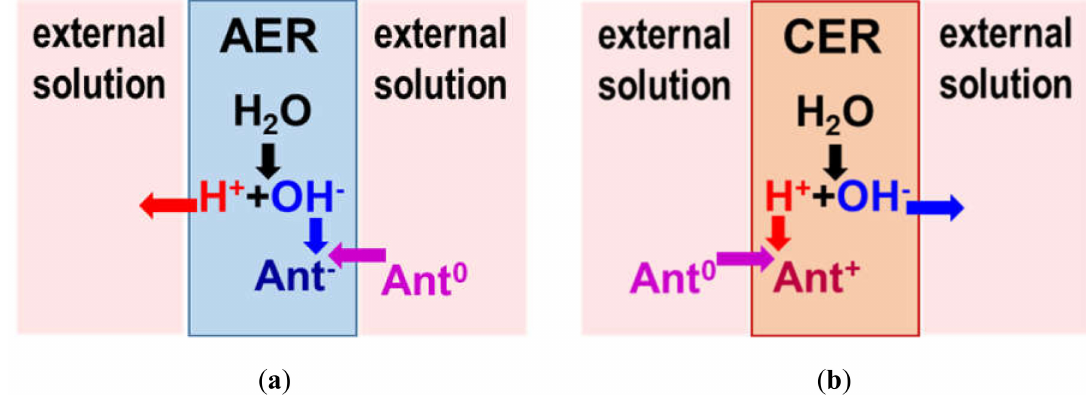
Figure 9. Schematic representation of the pH shift phenomenon in ( a ) anion-exchange resins (AERs), ( b ) cation-exchange resins (CERs), and external anthocyanin solutions (pH 6) surrounding the resins due to the Donnan exclusion of coions (H + or OH − ) that are the products of protonation / deprotonation